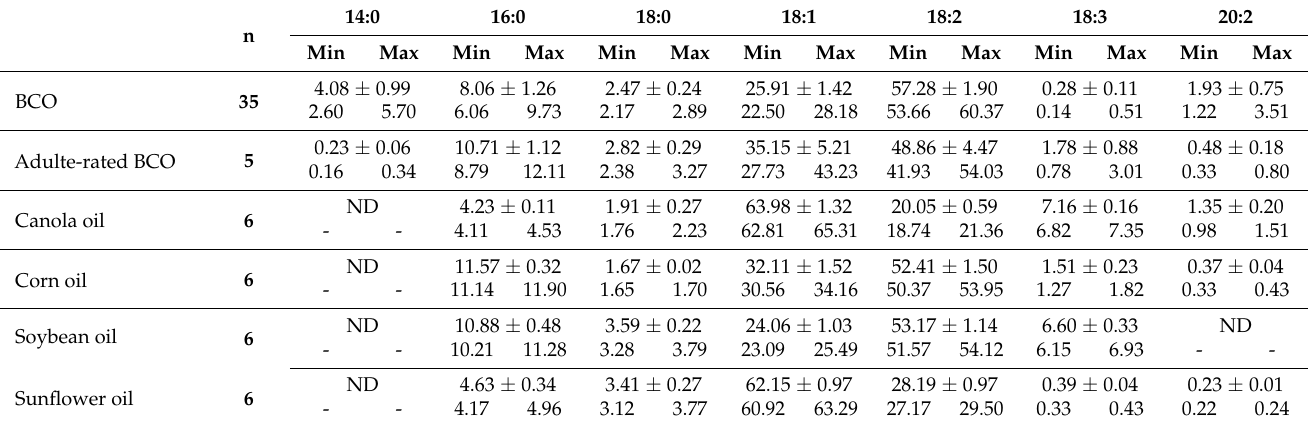
Table 1. Summary of fatty acid profiles of black cumin, canola, corn, soybean, and sunflower